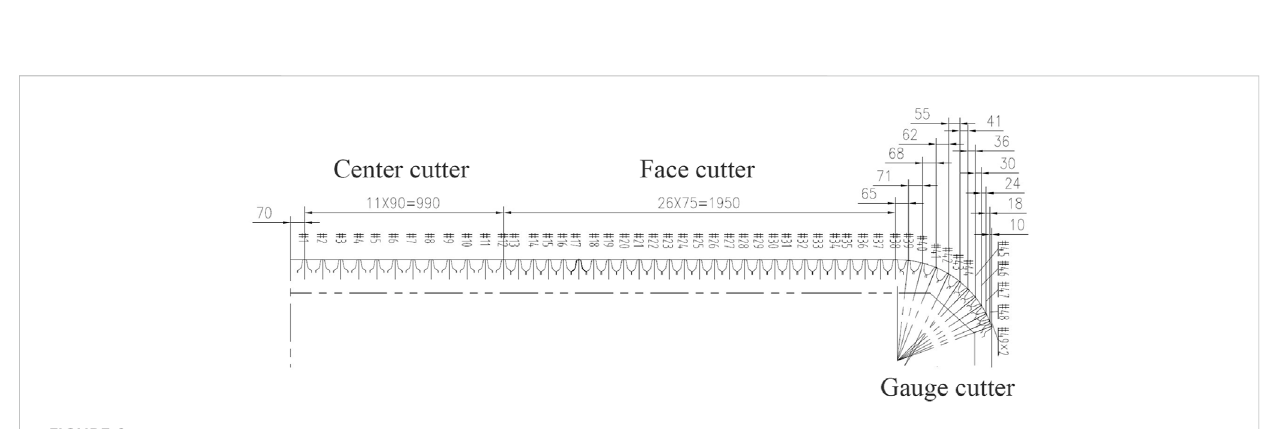
FIGURE 2 Schematic diagram of installation positions of disc